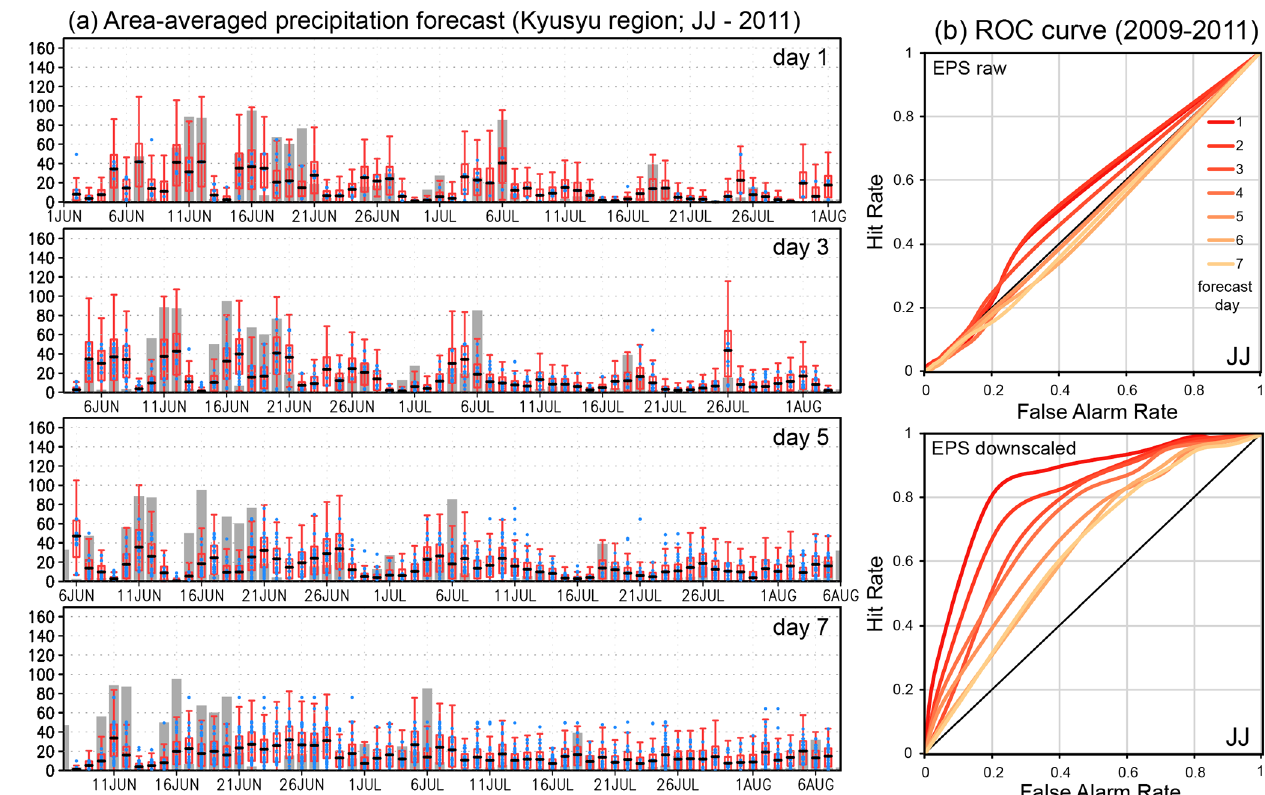
Figure 4. (a) Daily-mean precipitation obtained from the downscaling for the forecast day 1, 3, 5 and 7 during June–July. Composited PDFs of downscaled precipitation obtained from the SOM are represented by red error bar. The node-mean downscaled precipitation and its ensemble mean are represented by blue dots and horizontal bars, respectively. Observational precipitation (actual state) is represented by the gray bar. (b) ROC curves for the forecast days 1–7 for the precipitation of EPS raw and SOM downscaling during June–July at the periods